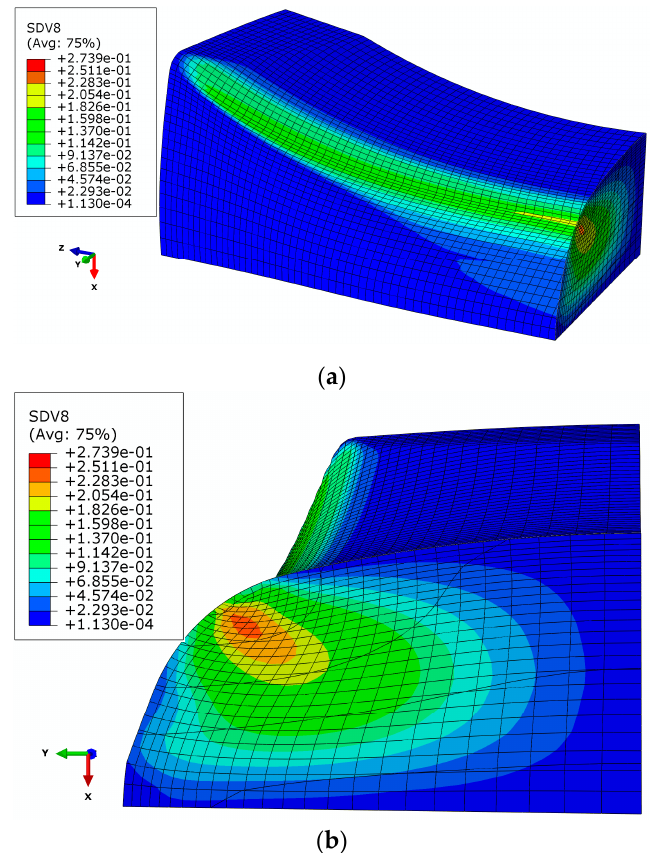
Figure 10. The damage elements of the billet after passing through the oval hole (the 3rd pass). ( a ) The main view. ( b ) The front view.